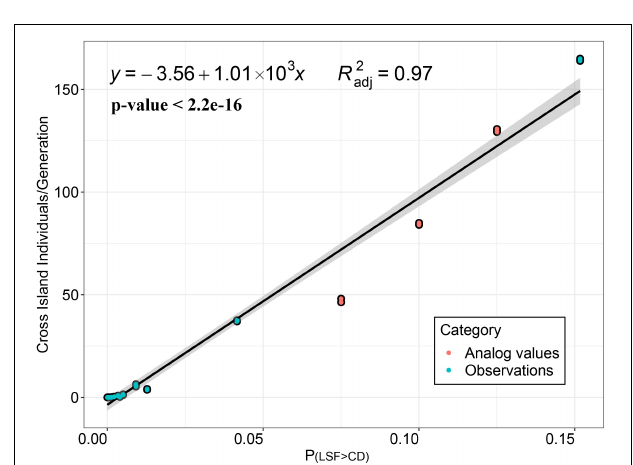
FIGURE 6 | Simulation of the relationship between P ( LSF > CD )) and cross-island individuals per generation in the process of species spreading from the mainland to island in 500 generations. Unary linear regression is shown in black and the CI is shown in gray. The blue points represent the P ( LSF > CD ) actually measured in the experiment (data come from measurements of 14 species), and the orange points represent the simulated point for supplementation (data come from simulation values of three hypothetical species). We repeated the simulation three times for each species. LSF, longest single flight; CD, closest